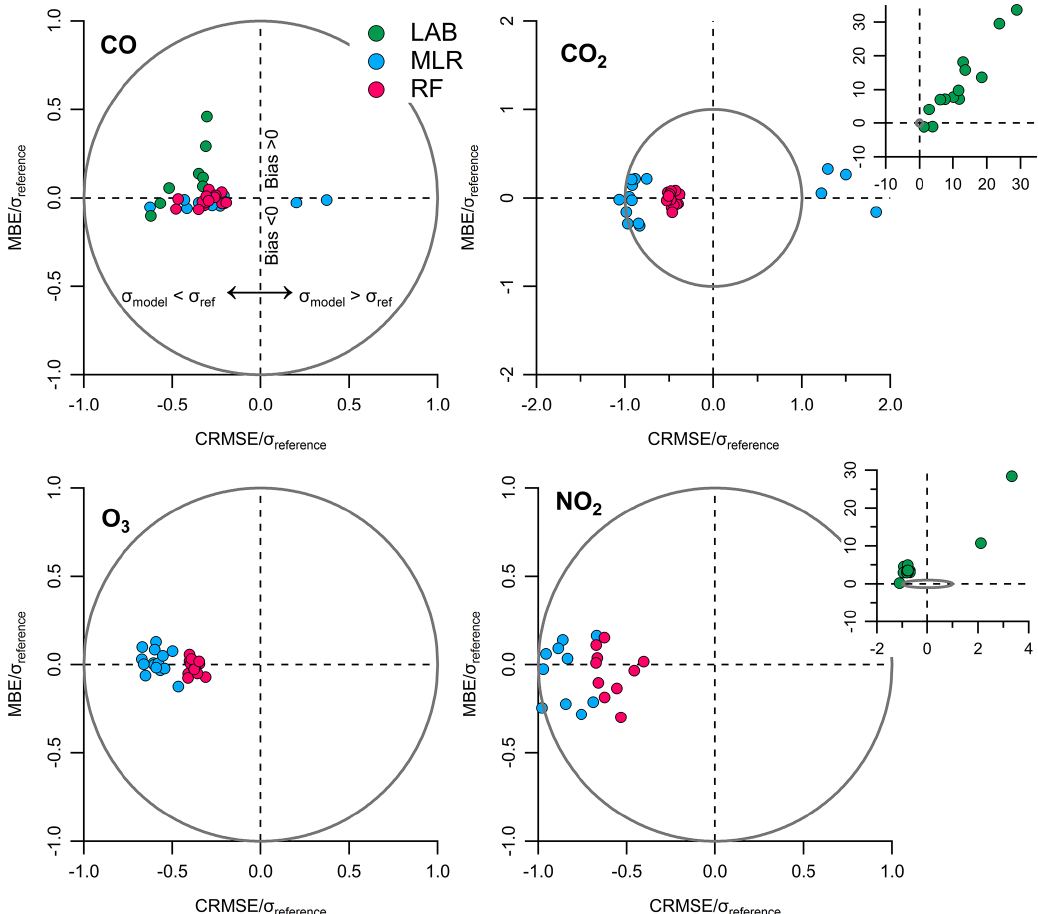
Figure 7. Target diagrams for CO, CO 2 , NO 2 , and O 3 to compare the LAB, MLR, and RF model performance. The y axis is the bias relative to the reference, and the x axis is the bias-adjusted RMSE (CRMSE) normalized by reference monitor standard deviation; the vector distance between any given point and the origin is the RMSE normalized by the standard deviation of the reference measurements. The CRMSE is in the left plane if model standard deviation is smaller than the standard deviation of the reference observations, and vice versa. If data fall within the circle, then the variance of the residuals is smaller than the variance of the reference measurements. The target diagram for the LAB model for CO 2 and NO 2 is shown in the inset figure because of the order-of-magnitude difference in MBE and CRMSE compared to the MLR and RF